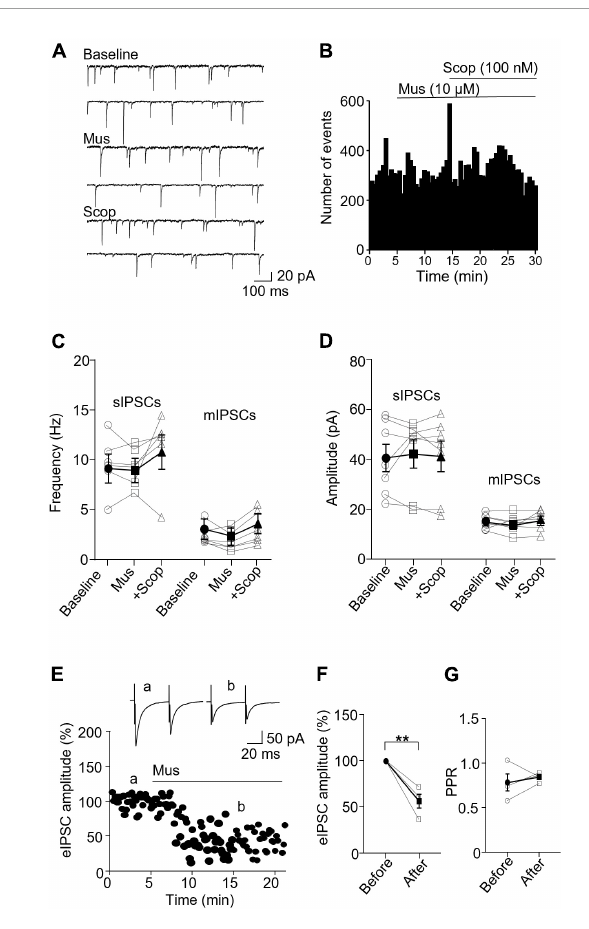
FIGURE5 Activation of mAChRs does not affect inhibitory synaptic activity in PV interneurons. (A) Representative traces of sIPSCs recorded from a PV interneuron before and after perfusion of muscarine. (B) A histogram shows the effect of muscarine and scopolamine on sIPSC frequency in the PV interneuron. (C,D) Summarized data show the effect of muscarine on sIPSC ( n = 6 cells/6 mice) and mIPSC ( n = 6 cells/5 mice) frequency and amplitude. (E) A representative experiment from a PV interneuron shows the effect of muscarine on evoked IPSCs. Insets: evoked IPSCs traces taken at the times marked by a and b in the graph. (F,G) Summarized data show the effect of muscarine on evoked IPSC amplitude ( n = 4 cells/3 mice) and paired-pulse ratio, respectively. ** p < 0.01.